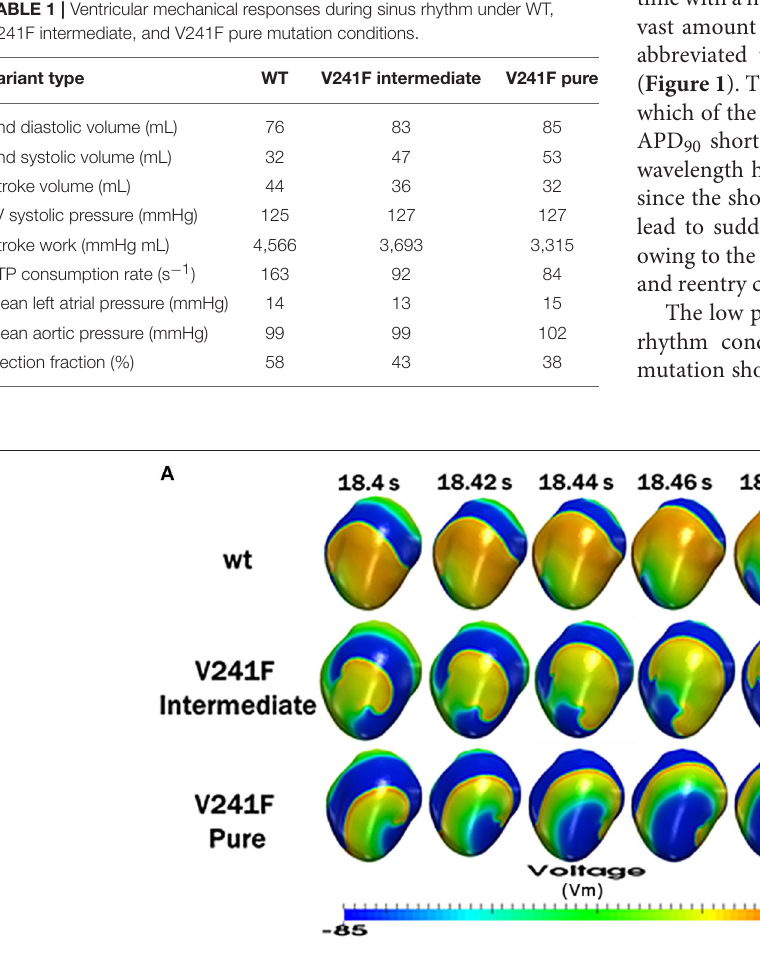
FIGURE 5 | Reentrant dynamics wave in the 3D ventricular tissue model for WT and V241F mutation conditions. (A) Snapshot of trans mural distribution of wt condition (top), Snapshot of trans mural distribution of V241F Intermediate (center), Snapshot of trans mural distribution of V241F Pure (bottom) of membrane potential; and (B) time traces of action potentials (AP) in